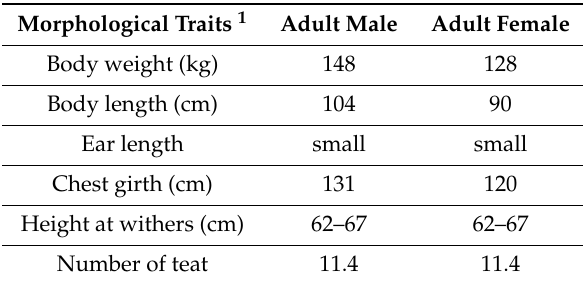
Table 1. Summary of morphology information.